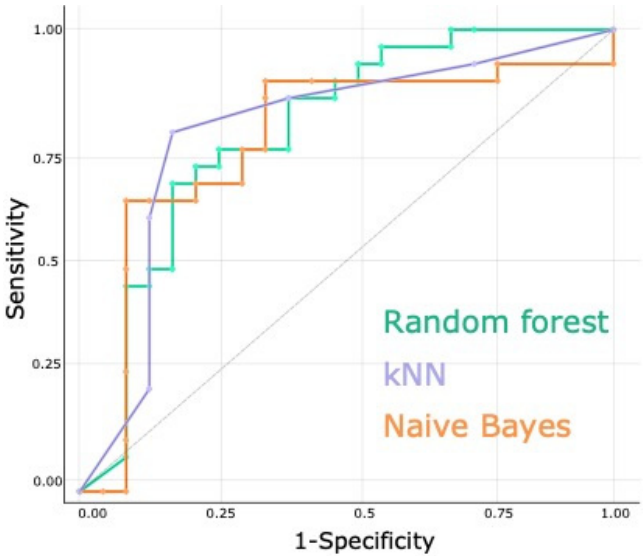
Figure 2. Head-to-head comparison of the receiver operating characteristic (ROC) curves for the classification accuracy yielded by SERS analysis of serum from renal cancer and control patients using three supervised classification algorithms (random forest, kNN, naïve Bayes). Table 2. The performance metrics for the classification of renal cell carcinoma and control group patients based on surface-enhanced Raman spectroscopy (SERS) spectra of serum using three clas- sification algorithms (random forest, kNN, and naïve Bayes). AUC—area under the curve; CA— classification accuracy; F1—score represents the harmonic mean of precision and recall; Precision— positive predicted values; Recall—sensitivity.